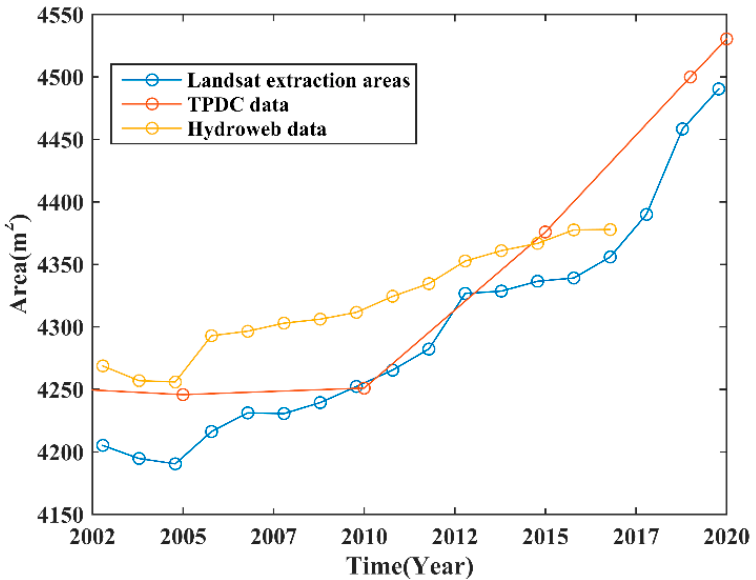
Figure 14. Comparison between the LQ area extracted from the Landsat image and that of the model data.